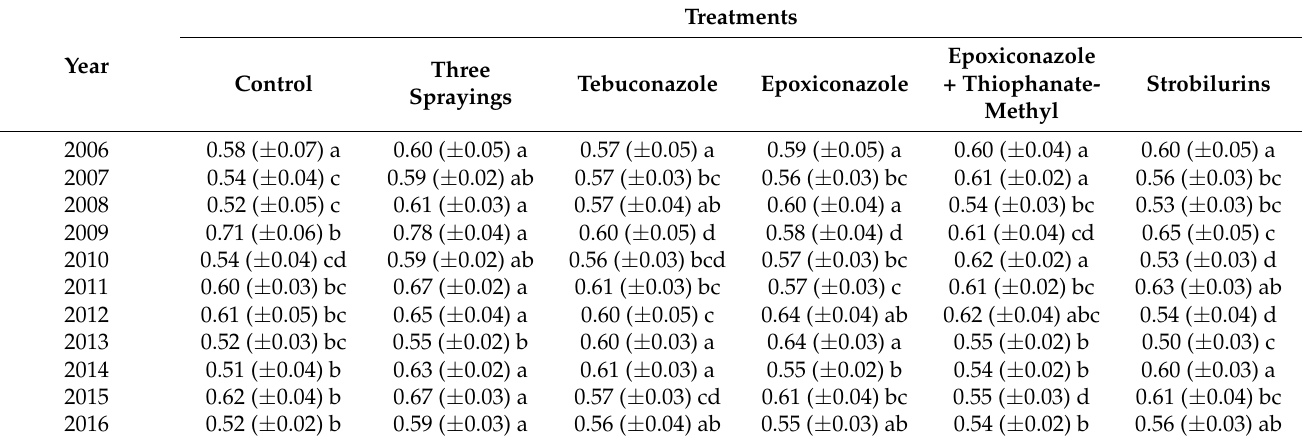
Table 8. Foliage index (FI) of sugar beet plants in the study years ( ± SD), by fungicidal protection